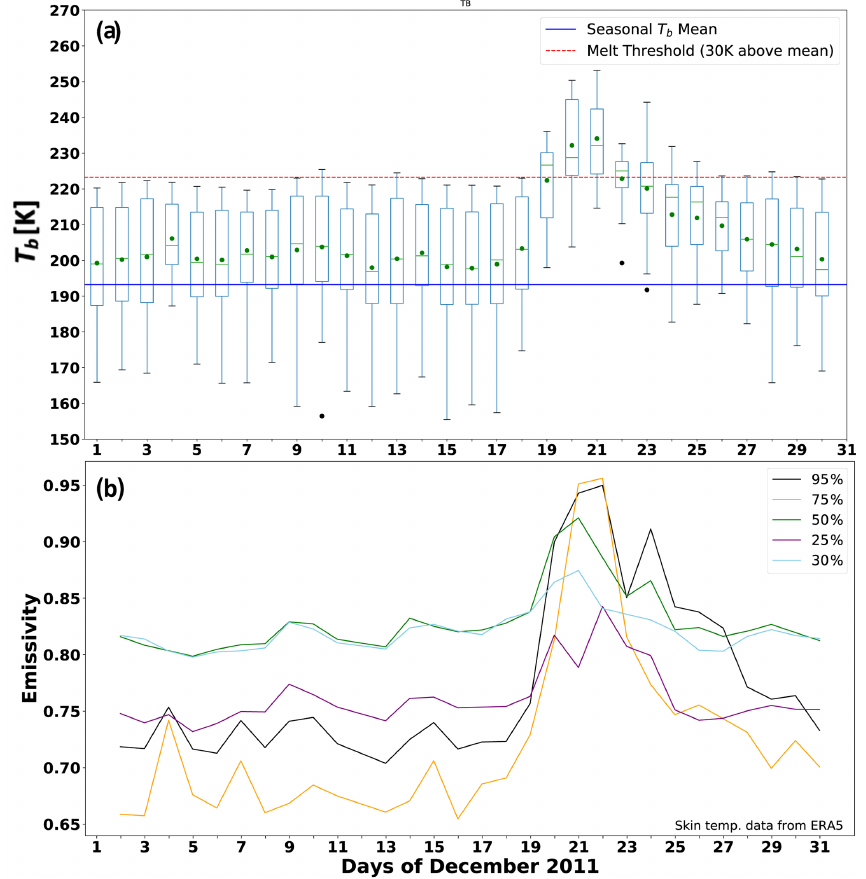
Figure 15. As in Fig. 3 but over the Pine Island and Thwaites Glacier region throughout December 2011. The five estimates of surface emissivity in panel (b) sampled from the region are referenced to the maximum T b value in the region on 21